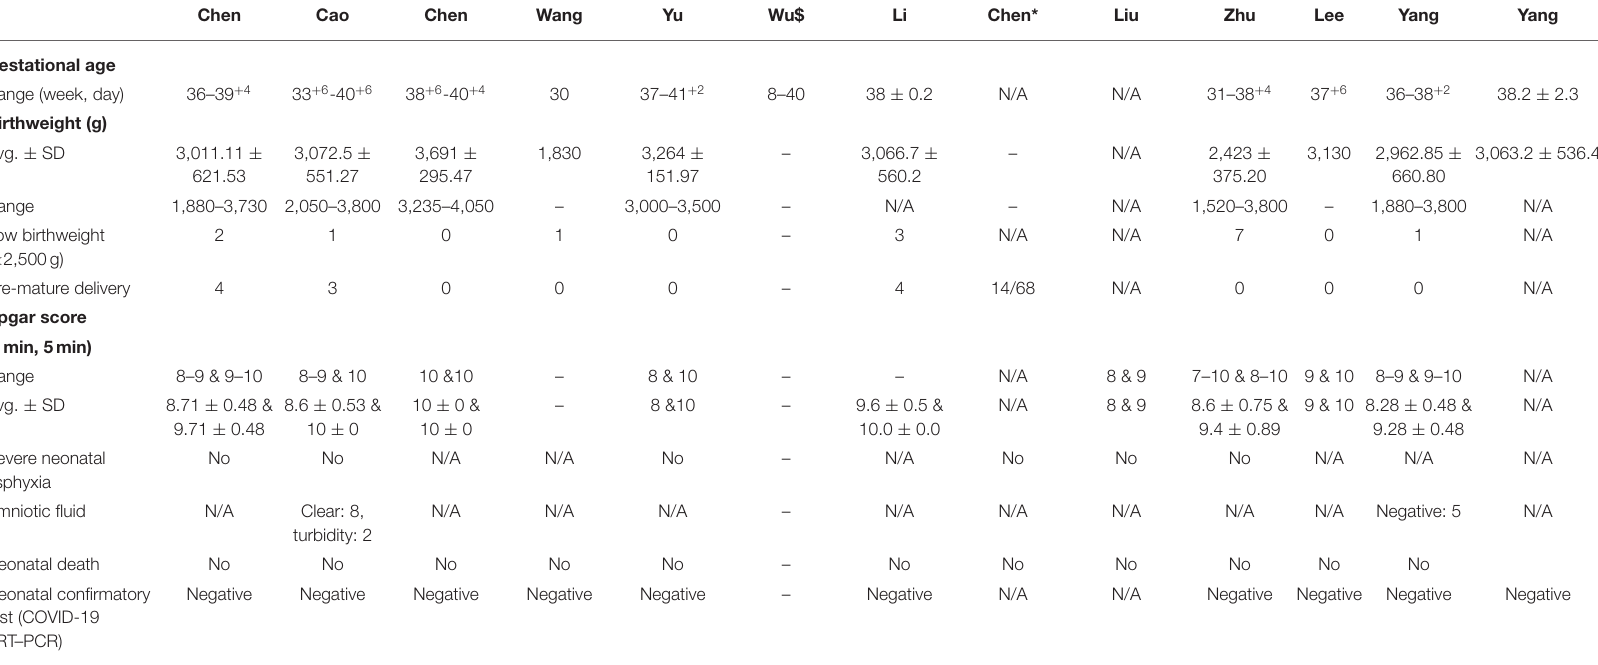
TABLE 3 | Neonatal outcomes of 235 COVID-19